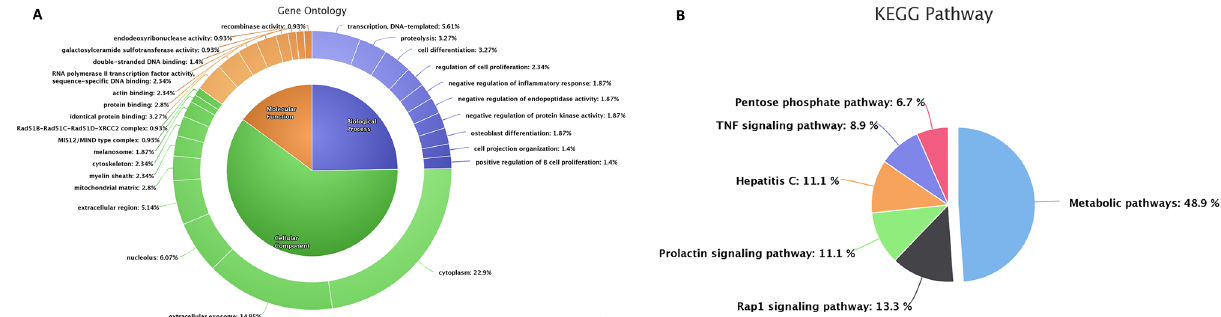
Figure 3. Gene Ontology and KEGG pathway analysis of translated proteins (overlap between transcripts and proteins). ( A ) Top 10 gene ontology categories. ( B ) KEGG pathway enrichment